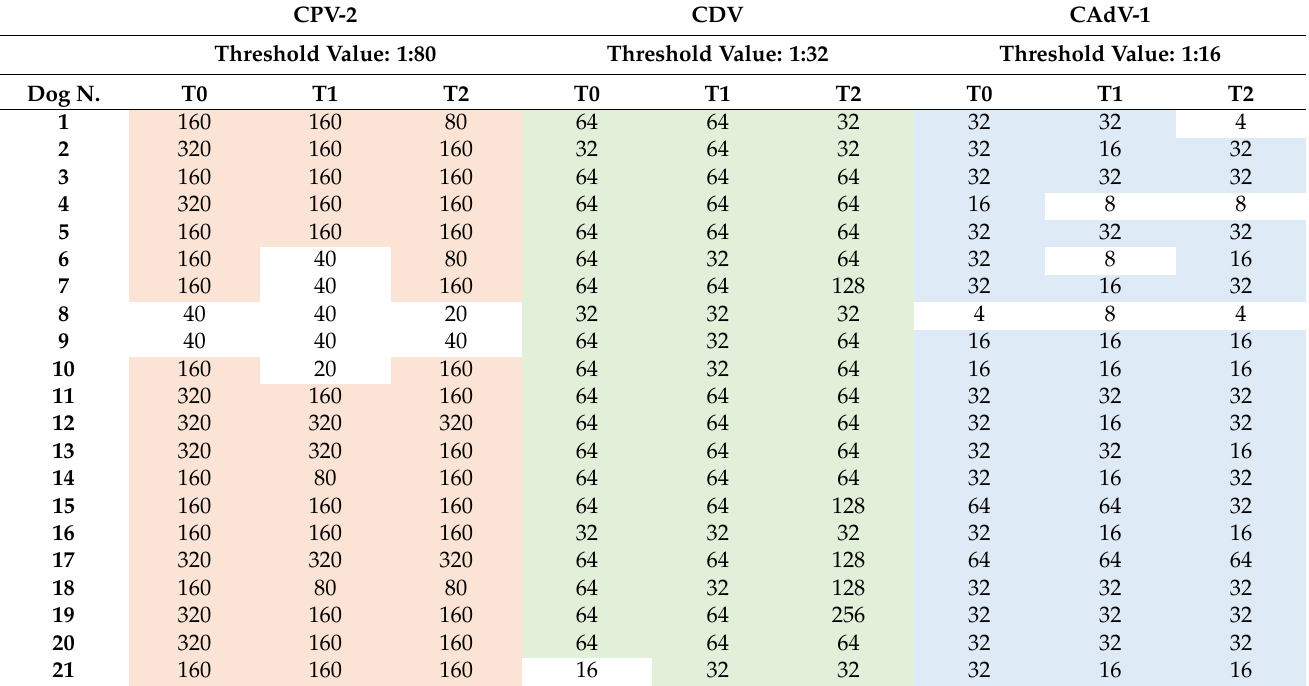
Table 3. Antibody titers specific for core vaccines (CPV-2, CDV, and CaAdV-1) at T0 (before